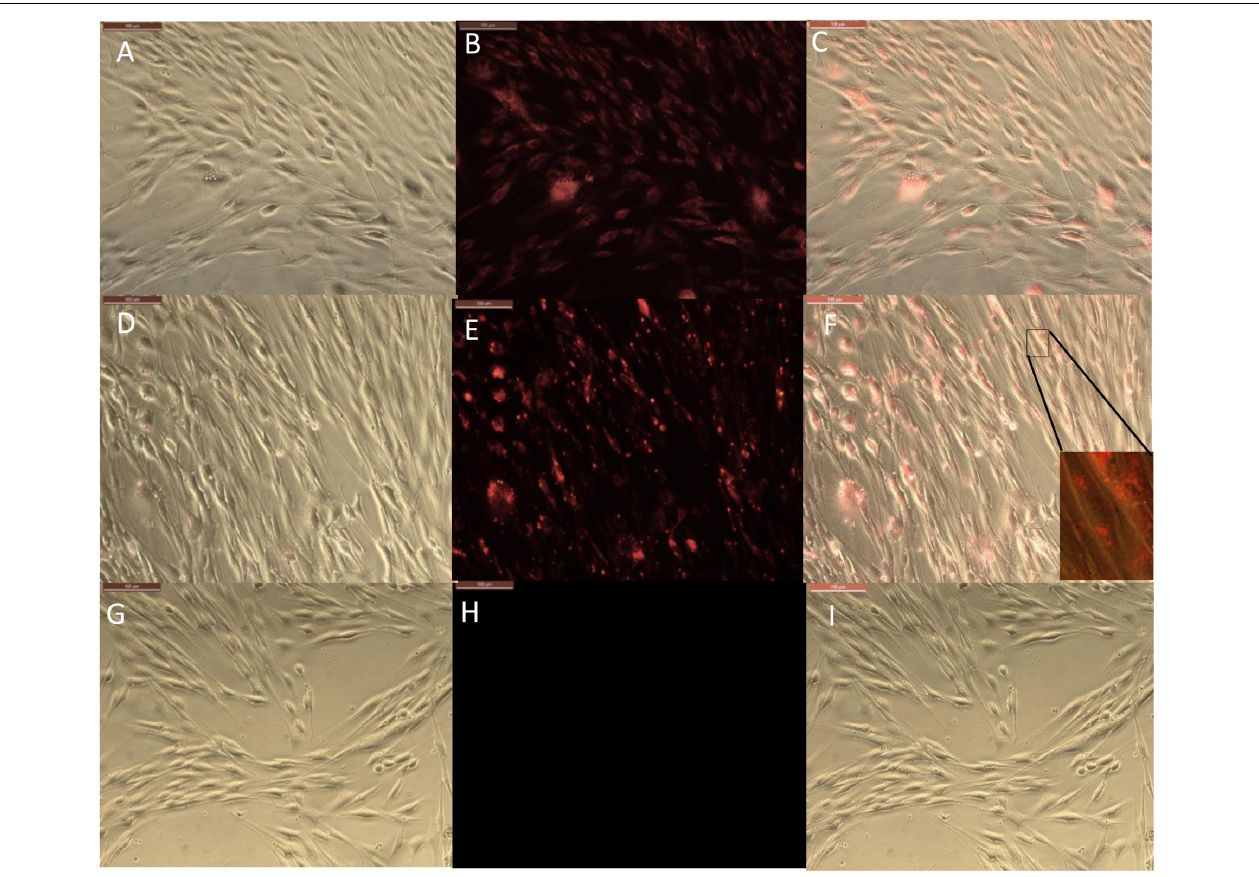
FIGURE 4 | Phase and fluorescence microscopic imaging of primary endothelial cells that were treated with RITC only (A,B) , treatment with HNT-RITC formulations (D,E) , and treatment with HNT only (G,H) in both phase (right) and fluorescent (middle) settings for 24 h exposure. Merged images for the phase and fluorescence settings (C,F,I) . Magnification = 200X, scale bar = 100 µ